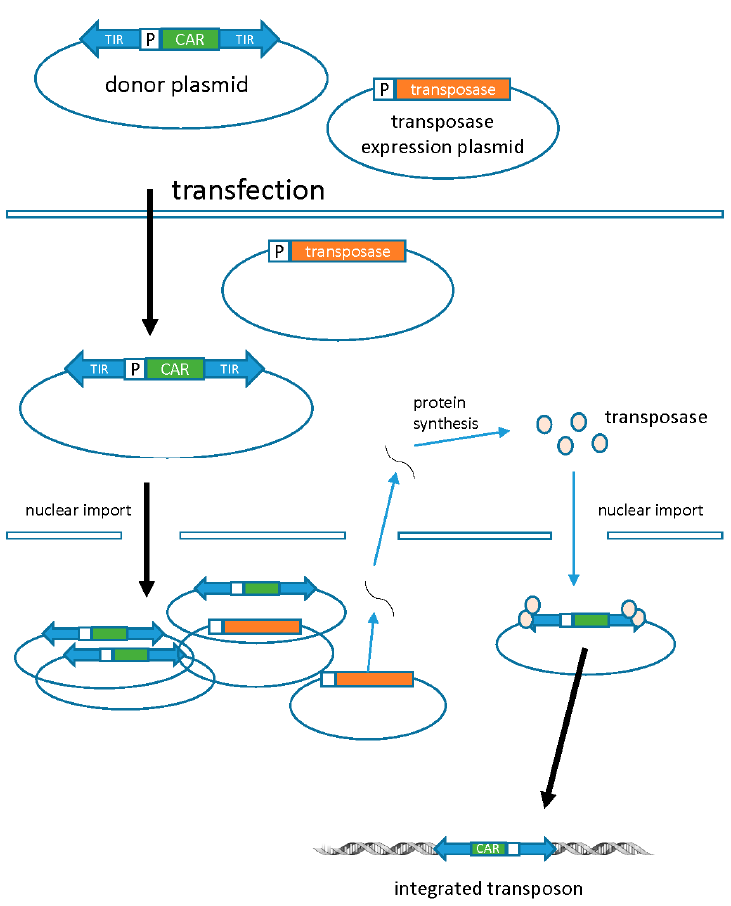
Figure 4. Transposons. Transposons are dual component systems composed of one plasmid carrying the CAR (transposon) and the other carrying the transposase. The transposase acts on the terminal inverted repeats flanking the CAR, which leads to excision and subsequent integration at a TA dinucleotide sequence in the target cell genome. DNA plasmids carrying the CAR (transposon) and transposase are electroporated into PBMCs. Following transposition and stable genomic integration, the CAR protein is expressed on the surface of the T cell. TIR, terminal inverted repeats; P, promoter. Adapted from Cai & Mikkelsen [54].